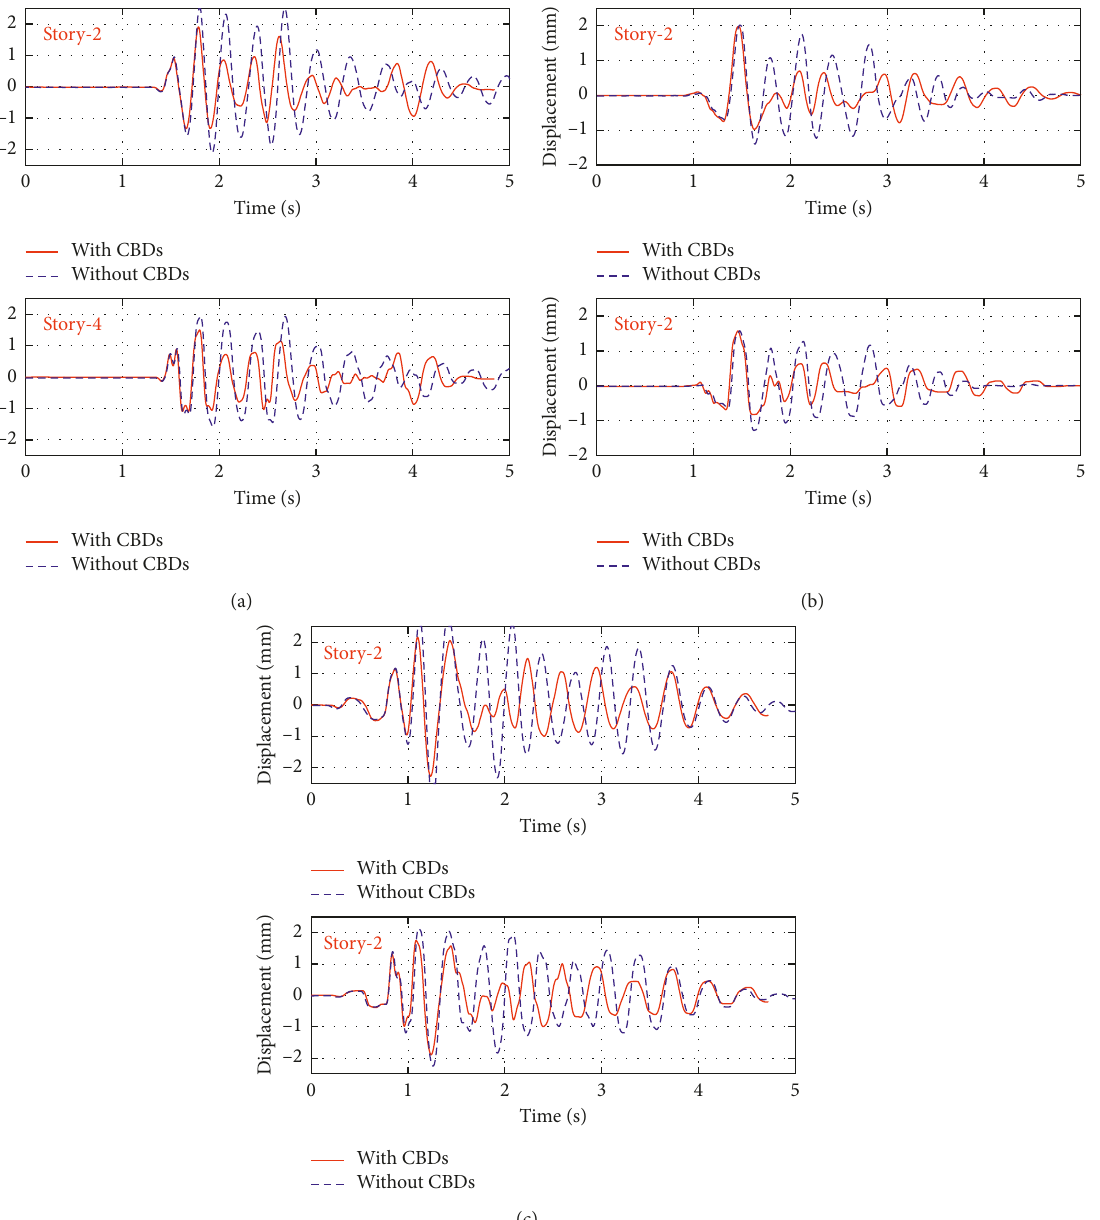
Figure 14: Time-history comparison of interstory displacements under moderate-intensity earthquakes: (a) El Centro, (b) Impvall, and (c)